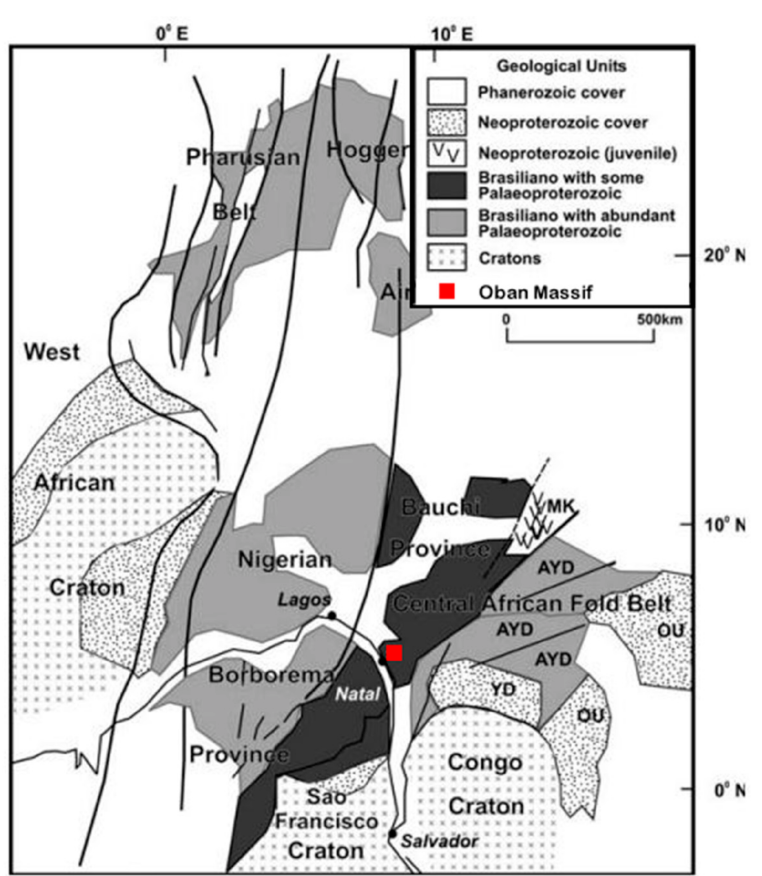
Figure 3. Pre-drift Paleo-proterozoic belts between Africa and NE South America (Modified af- ter [29]). AYD, Adamawa-Yade domain; MK, Mayo Kebi terrain; OU, Oubanguide fold belt; YD, Yaounde